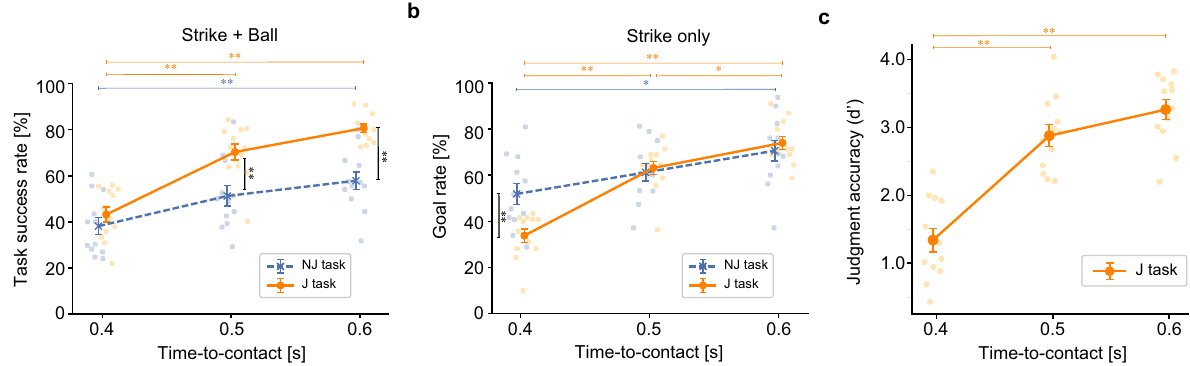
Fig. 2 TTC-dependent changes in task success rate, goal rate, and judgment accuracy. a , b The mean task success rate for Strike and Ball targets ( a ) and the mean goal rate for only Strike targets ( b ) for each TTC are plotted as orange lines (the J task success rate) and blue dashed lines (the NJ task success rate) (Mean ± SEM, n = 12, * p < 0.05, ** p < 0.01). The individual data points are overlaid. c The mean judgement accuracy (d ′ ) for each TTC is shown by orange lines (Mean ± SEM, n = 12, * p < 0.05, ** p < 0.01) with individual data points overlaid. Please note that the J task success rate and judgment accuracy decreased as TTCs were shortened, and judgment was ineffective in terms of J task success rate if TTC was <0.5 s.